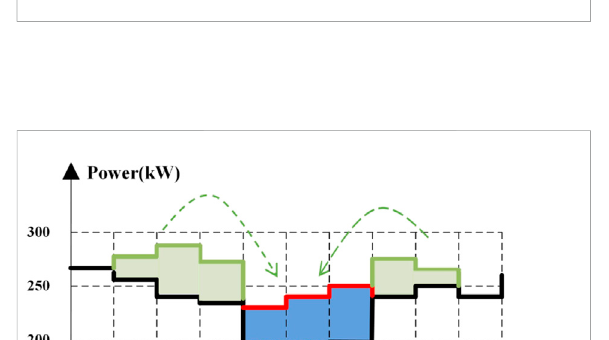
FIGURE 2 Demand response bidding curve.